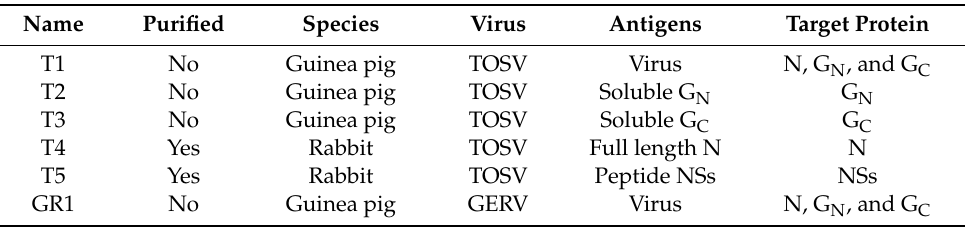
Table 1. List of polyclonal antibodies generated in this study.